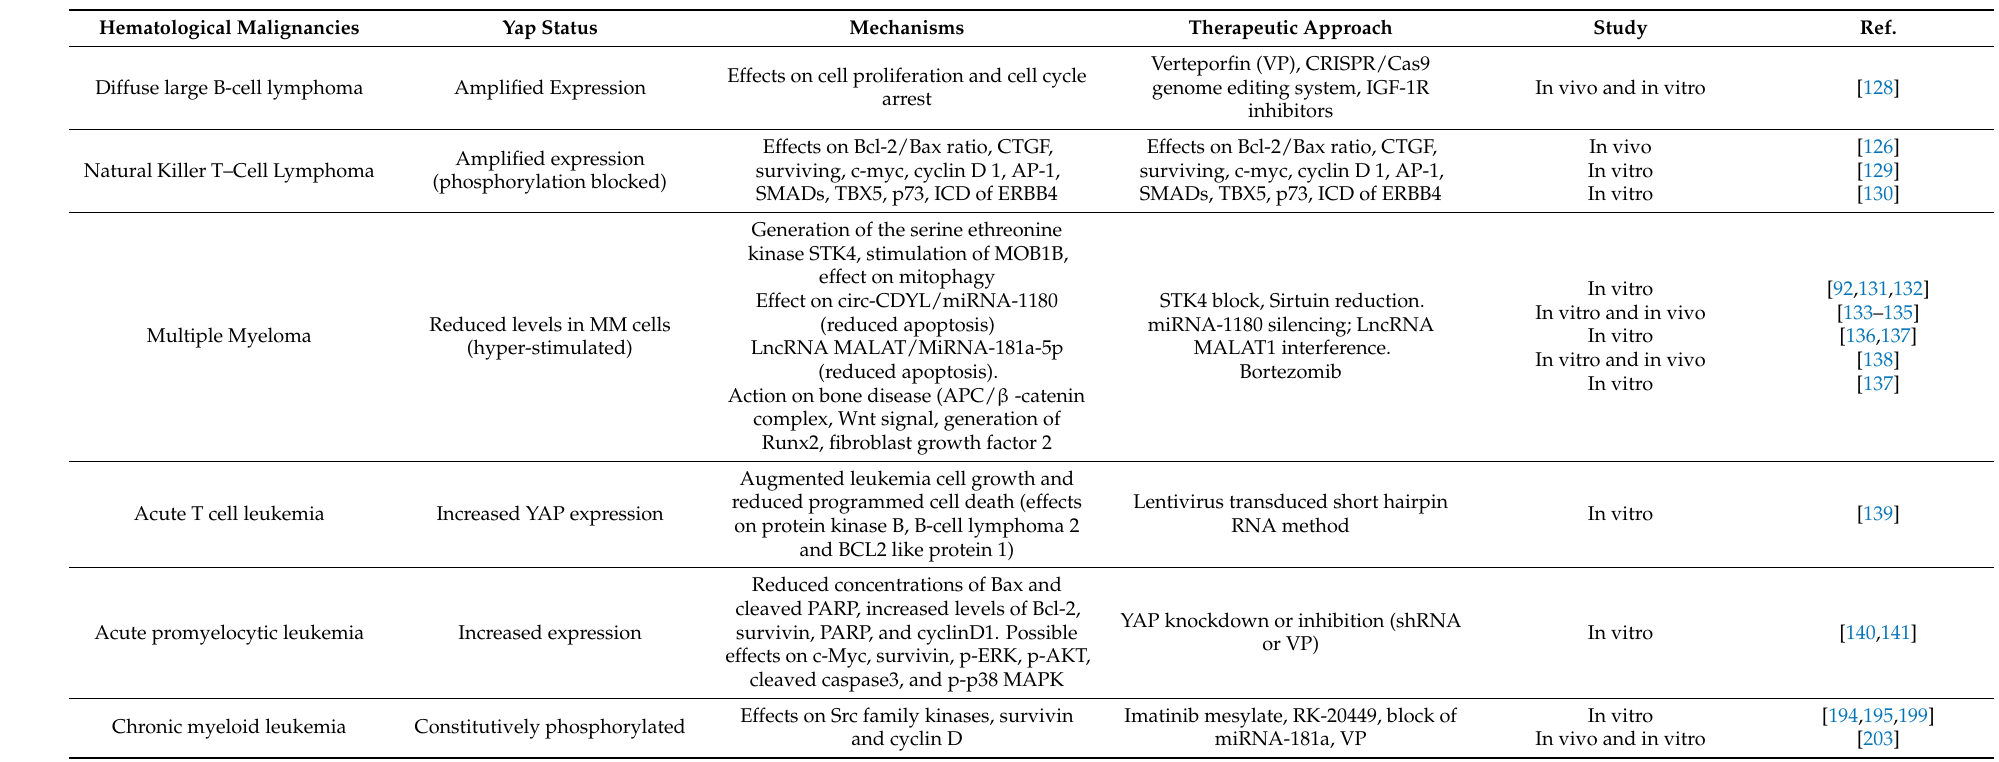
Table 1. Principal interactions between YAP system and hematological